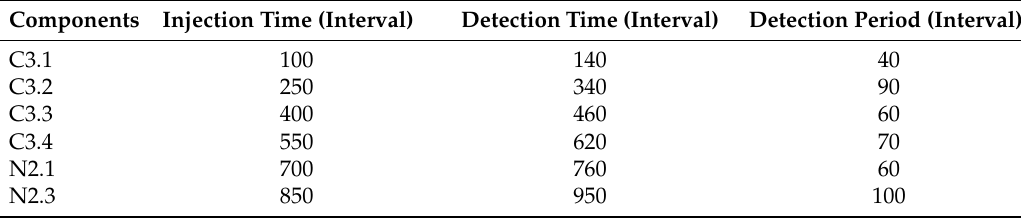
Table 6. CPU hog detection using HHMM.